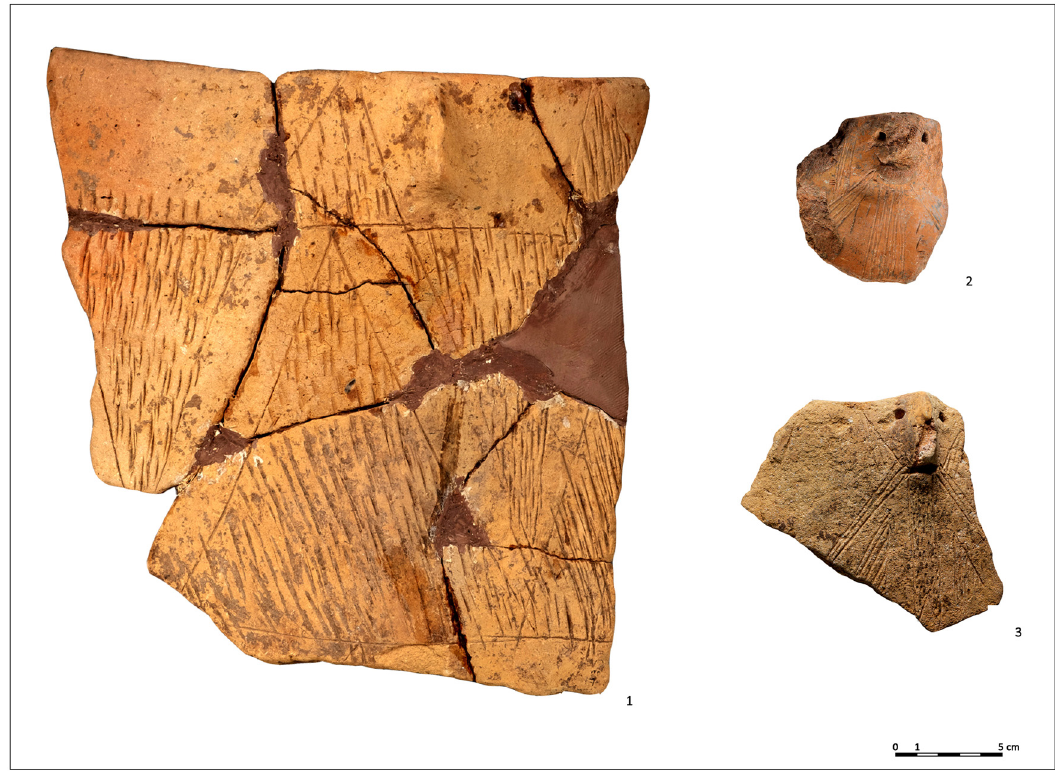
Figure 3: Vessels with human face ( 1 ) and whole - body human fi gures ( 2 – 3 ) from Grotta delle